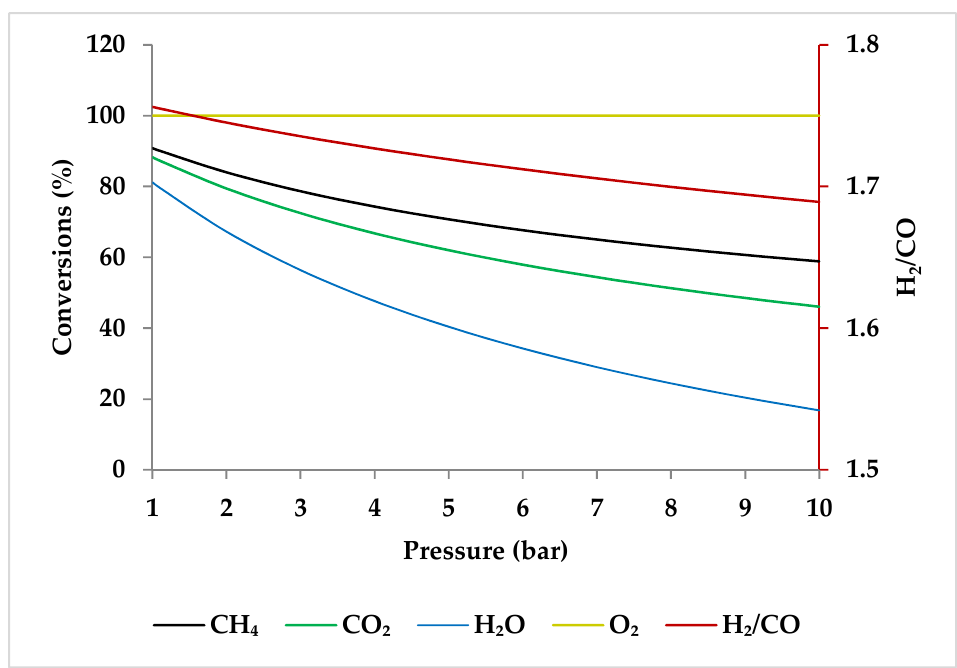
Figure 10. Effect of pressure on the feed gas conversions at 750 °C with molar ratio of CH 4 :CO 2 :H 2 O:O 2 = 1:0.3:0.3:0.2.